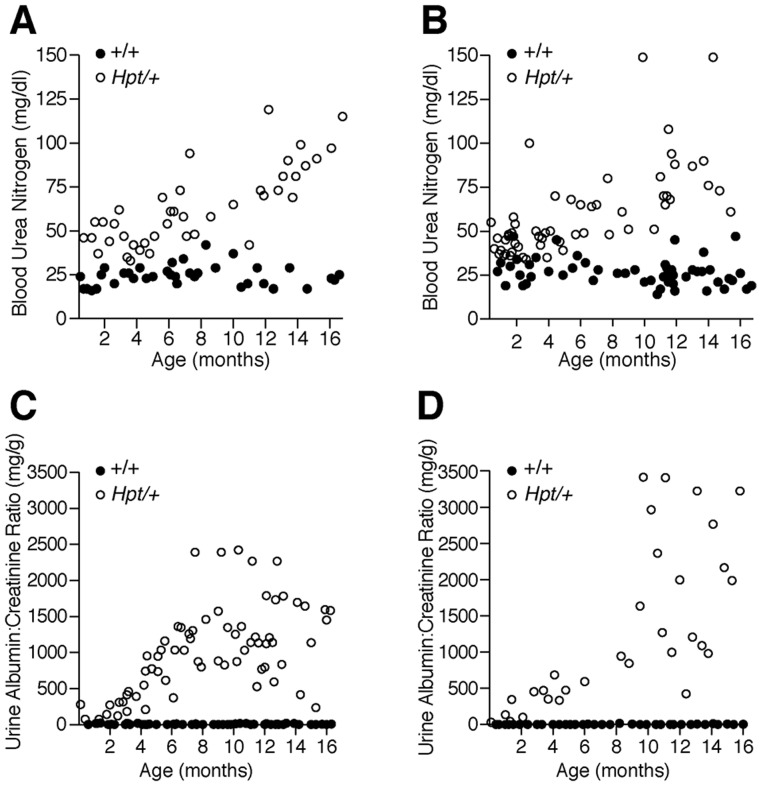
Renal function.A (male), B (female). Blood urea nitrogen (BUN) levels in individual Hpt/+ and +/+ mice. C (male), D (female). Urine albumin:creatinine ratio (ACR) in individual Hpt/+ and +/+ mice. Renal function progressively declines in the Hpt/+ animals. BUN values are significantly elevated (p<0.05) in Hpt/+ male (A) and female (B) mice compared with sex-matched +/+ controls at all time points (unpaired two-tailed T-test with Welsh’s correction). Urinary ACR is significantly elevated (P<0.05) as early as one month of age in males (C) and by three months of age in females (D) (unpaired two-tailed T-test with Welsh’s correction).